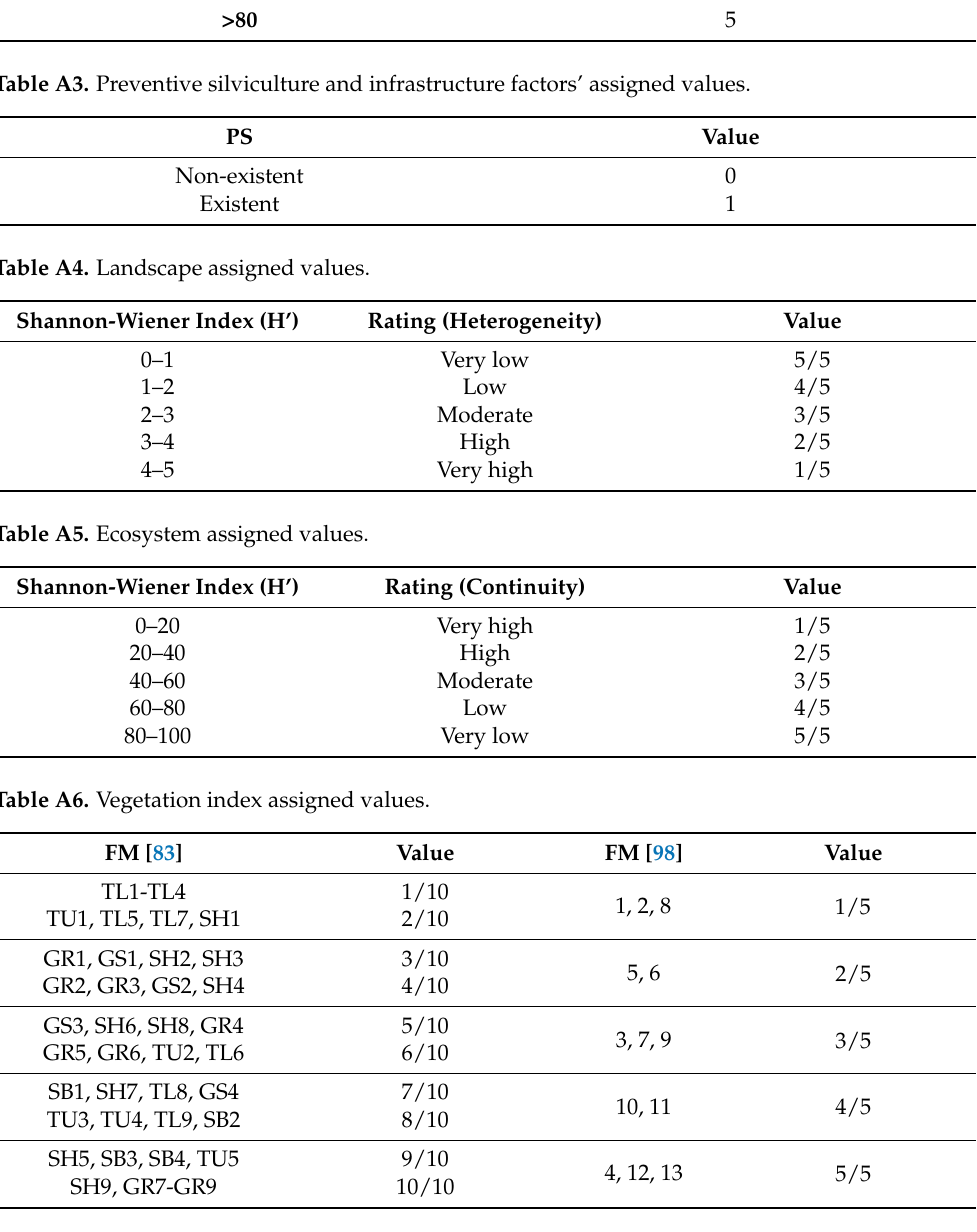
Table A7. Thermicity Index for Mediterraneas cases assigned values